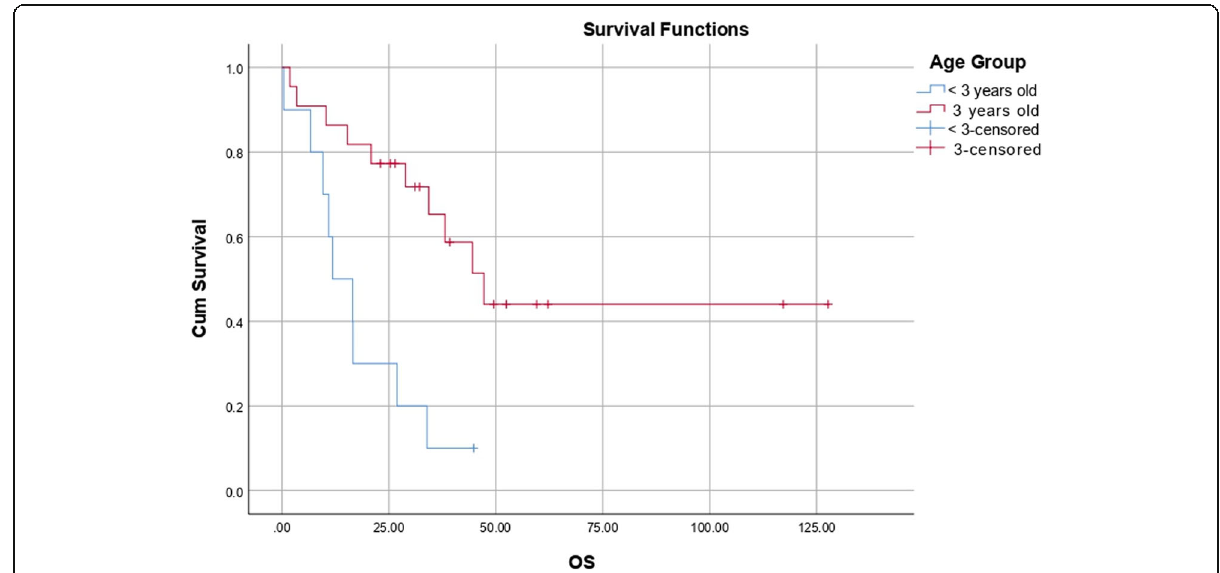
Fig. 2: Correlation between patients ’ ages and overall survival